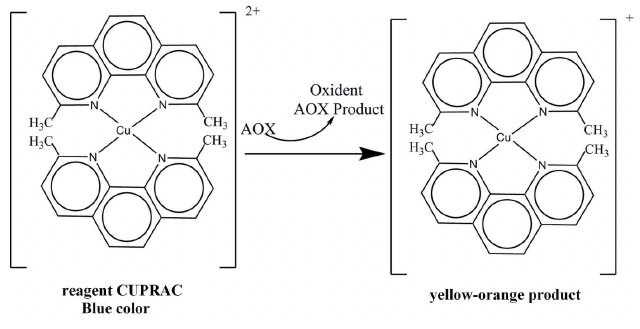
Figure 6 Reduction of the chromogenic complex of Cu +2 –Nc